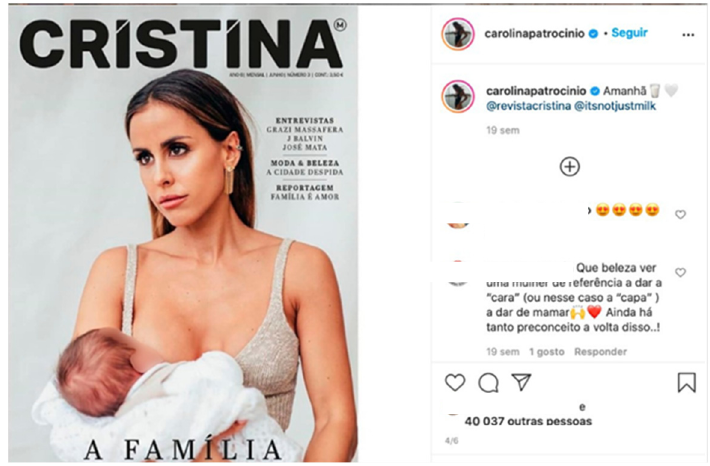
Figure 5. Example of “Professional content”; Instagram @carolinapatrocinio, Post, 4 June 2020.